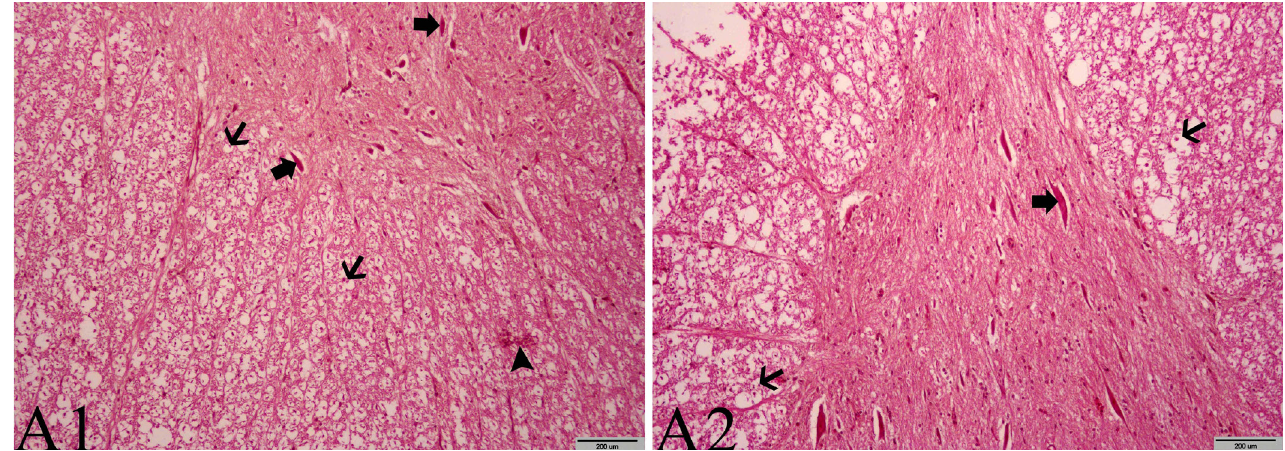
Fig. 1 - Effects of propolis on the damage caused by ischemia/reperfusion of the spinal cords of rabbits. All shapes are stained with HE. (A2) 10x and 200 µm VE (A1) 20x and 100 µm were used as the original magnification. A1: Thick arrows: chromatolysis and loss of Nissl granules in neurons. Thin arrow: formations of diffuse spherical shape. Arrowhead: focal mononuclear cell infiltration areas. A2: Thick arrow: chromatolysis and loss of Nissl granules in multipolar neurons. Thin arrows: spherulite formations.